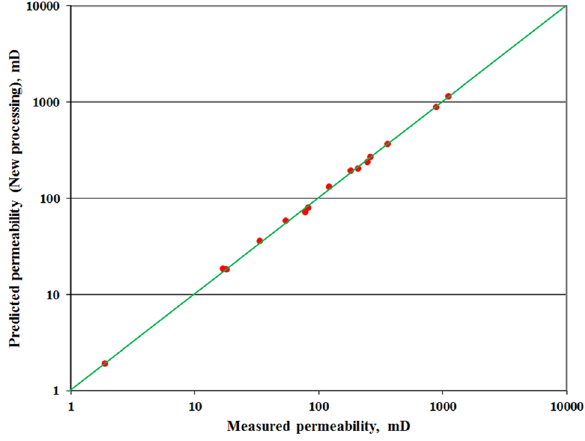
Fig. 7 Measured permeability versus predicted one using the new